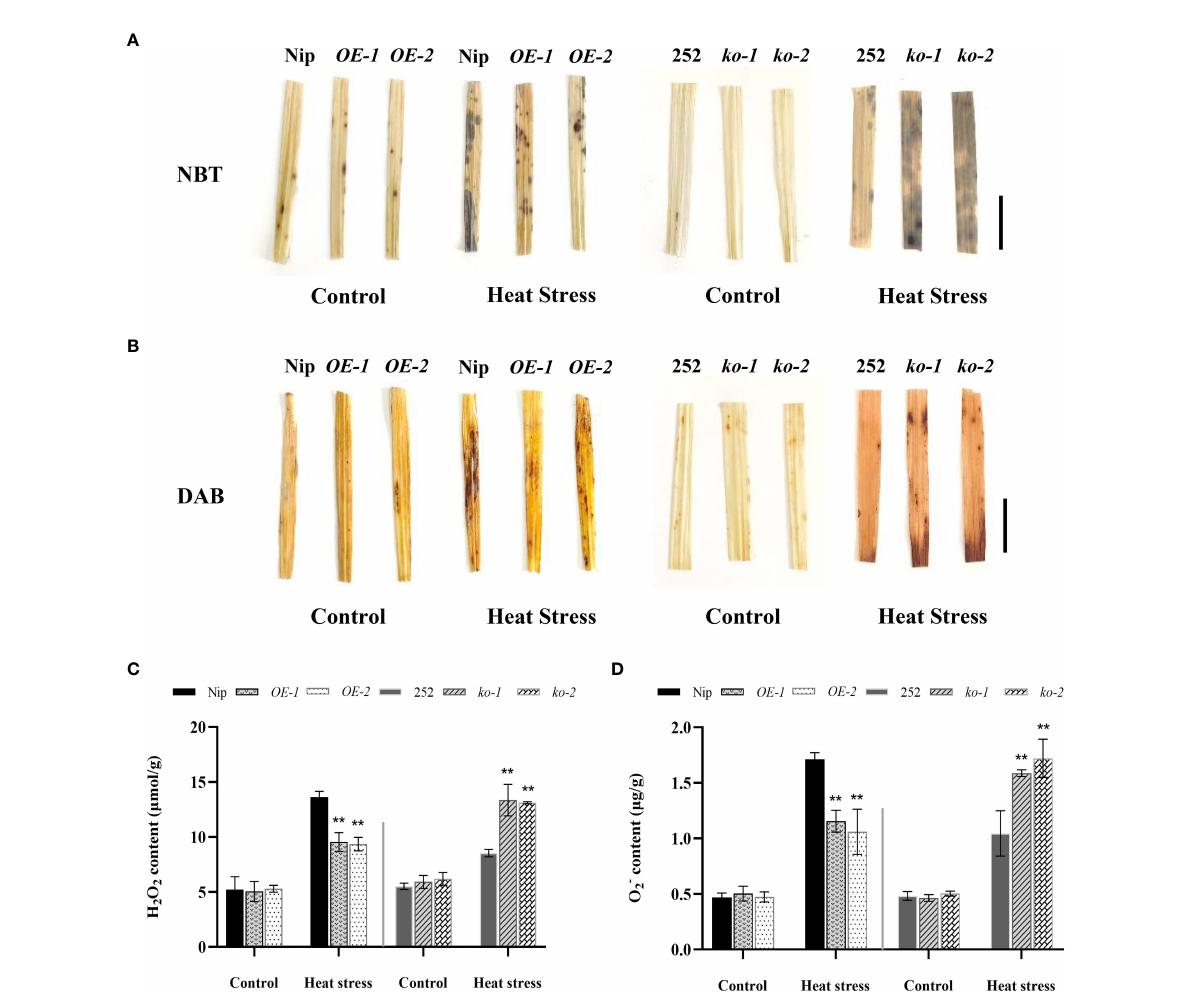
FIGURE 4 Accumulation of H 2 O 2 and O 2- in seedlings under heat stress. (A) O 2- production in leaf discs of WT and transgenic lines upon heat exposure. Bar = 1 cm. (B) H 2 O 2 accumulation in leaf discs of WT and transgenic lines upon heat exposure. Bar = 1 cm. (C) Quantitative measurement of total H 2 O 2 content in WT and transgenic lines upon heat exposure. (D) Quantitative measurement of total O 2- content in WT and transgenic lines upon heat exposure. Data are means ± SD (n = 3; **P < 0.01, Student ’ s t